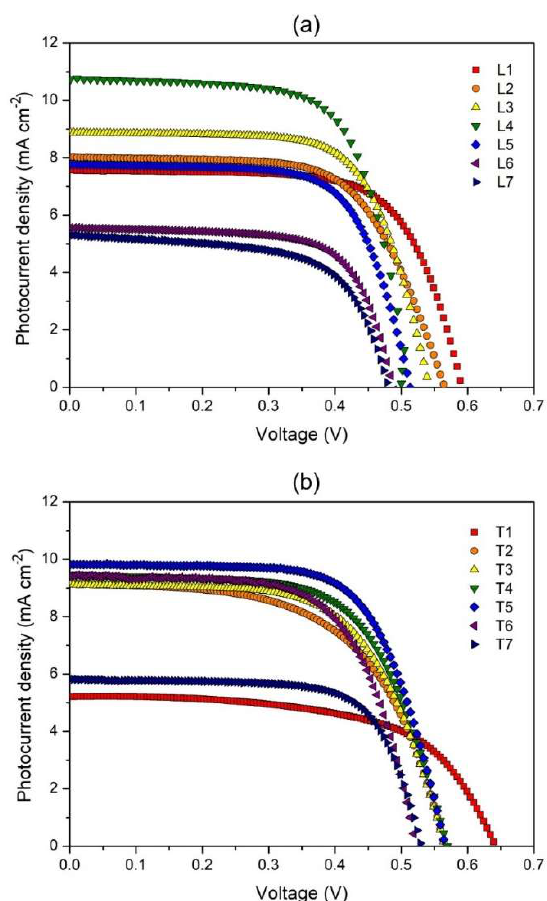
Figure 8. JV curves of PhSt-HEC-DMF with ( a ) LiI and ( b ) TPAI gels.